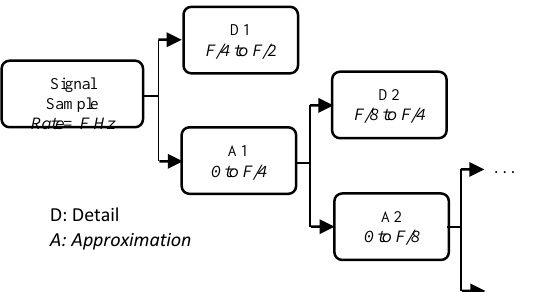
Figure 1. Diagram of multi-resolution analysis of wavelet.